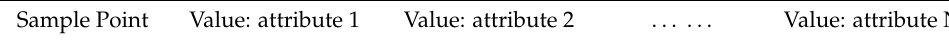
Table 1. The structure of a data sample.